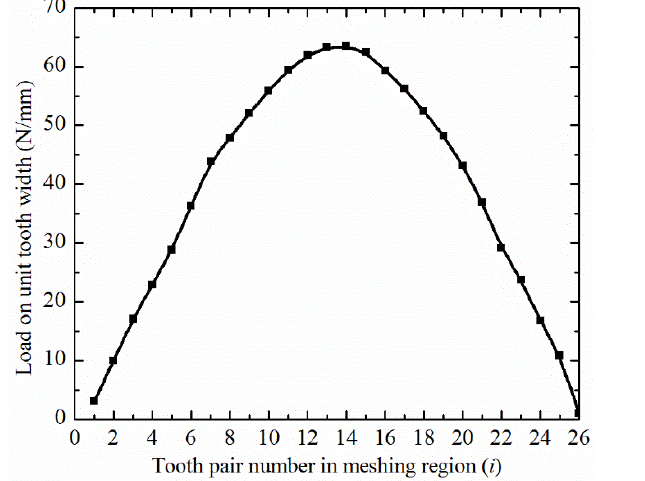
( b ) Figure 21. ( a ) Equivalent stress of the rigid wheel after loading; ( b ) equivalent deformation of the rigid wheel after loading. As shown in Figure 22, during one engaging-in and engaging-out cycle of a tooth pair in the meshing region of the disposable HD, the load on the teeth of the gear gradu-